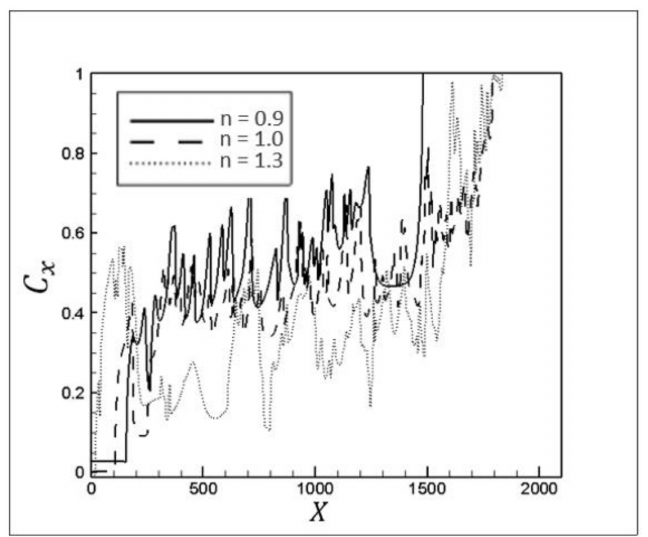
Figure 20. Transverse displacement efficiency over the channel length for different n.